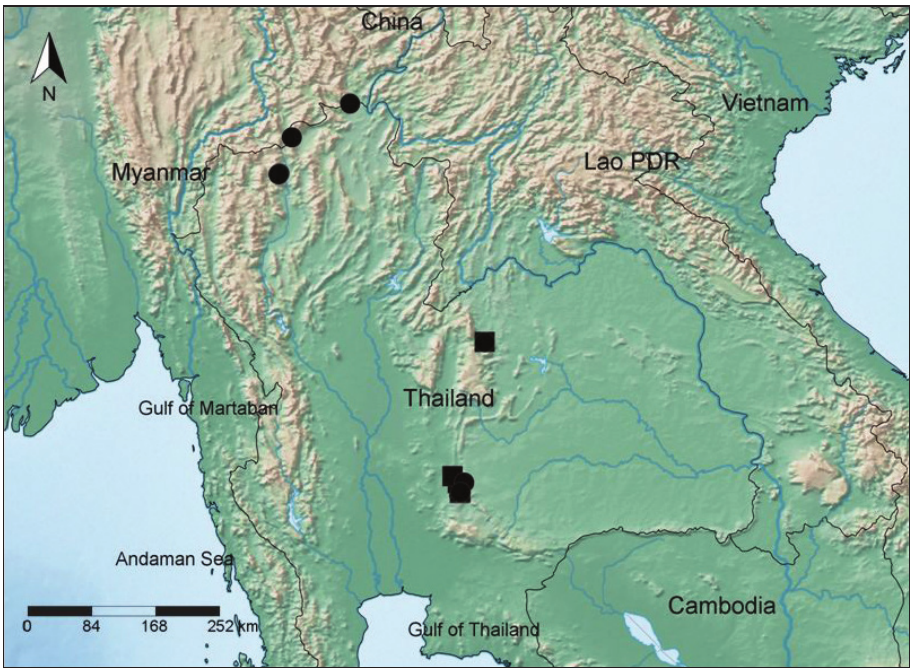
Figure 4. A map showing the distribution of Dracaena kaweesakii in northern, northeastern and central Thailand based on both specimen data (  ) and observations (  ). Map Created with SimpleMappr, http:// www.simplemappr.net (Shorthouse